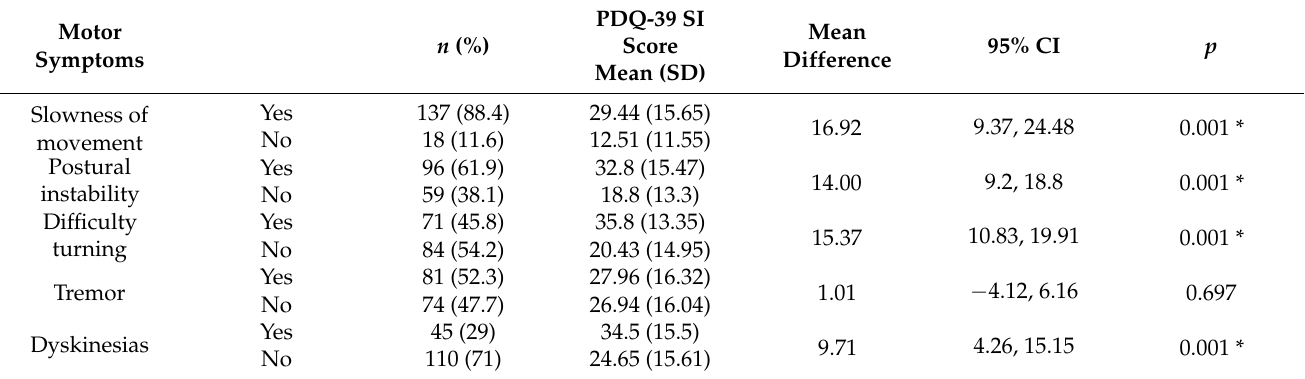
Table 4. Relationship between the PDQ-39 SI and the presence of MS.